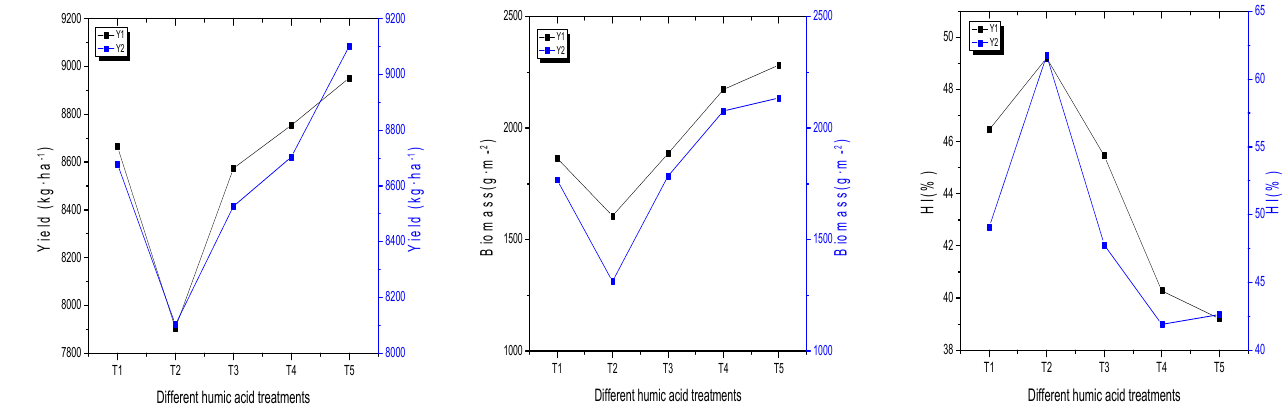
Figure 4. The yield, biomass, and the HI under the different HA